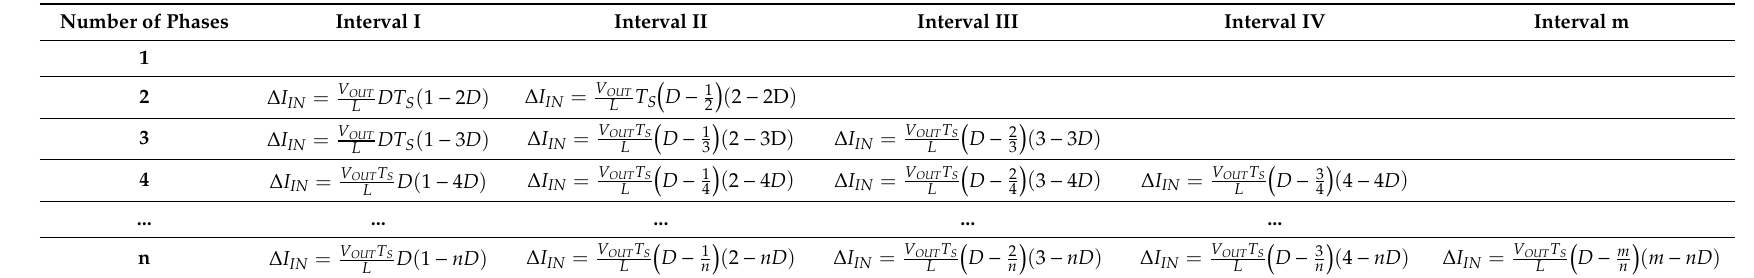
Table A1. The equations of output current ripples for the 2-,3-, 4- and n-phase non-modular boost converter.